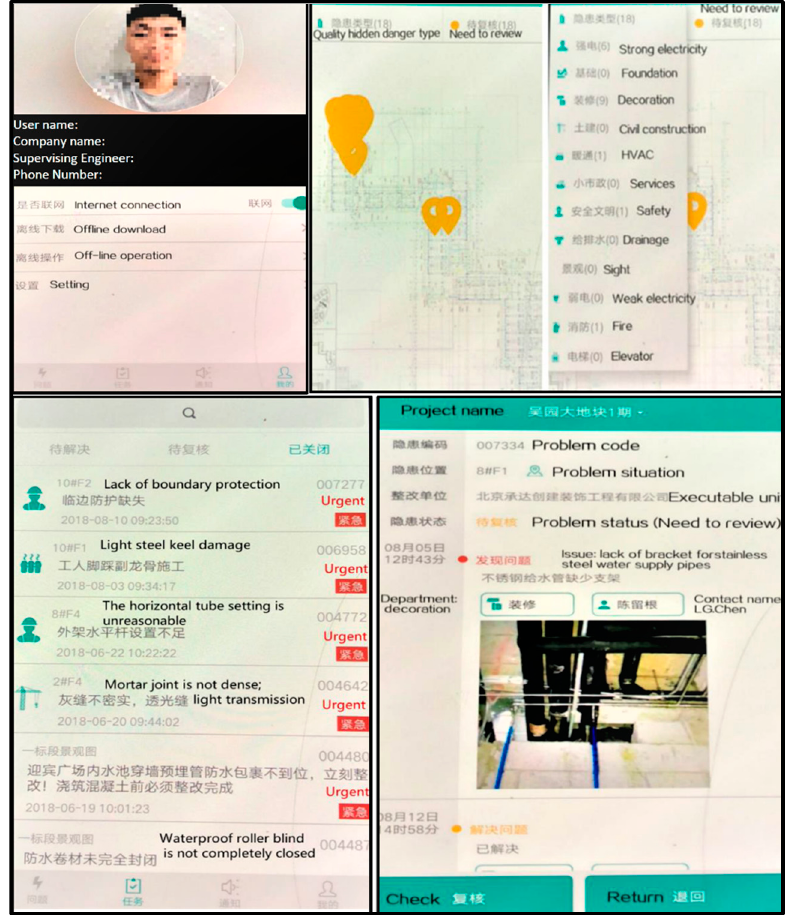
Figure 2. Mobile application interface of the developed IBMS ( top left ); demonstrating real-time data capture ( top right ); problem log ( bottom left ); inspection and reporting ( bottom right ).